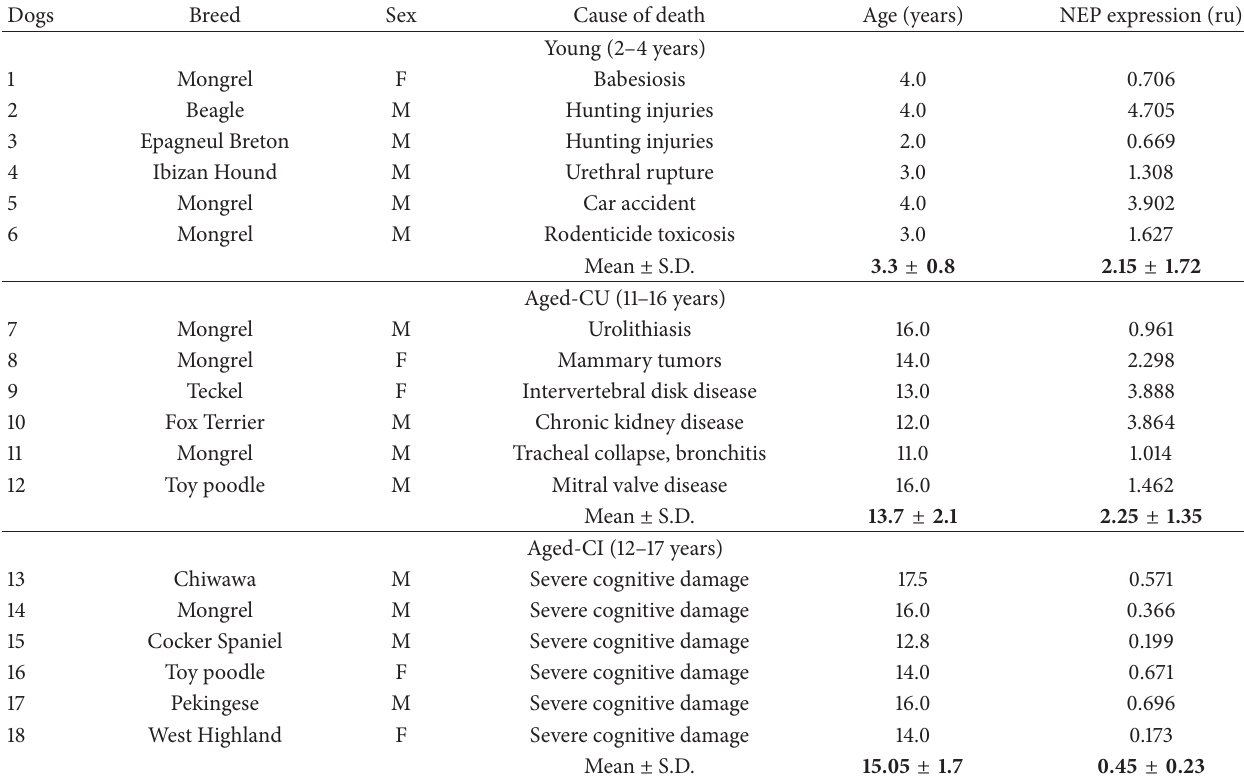
Table 1: Characteristics and NEP expression values of the animals.